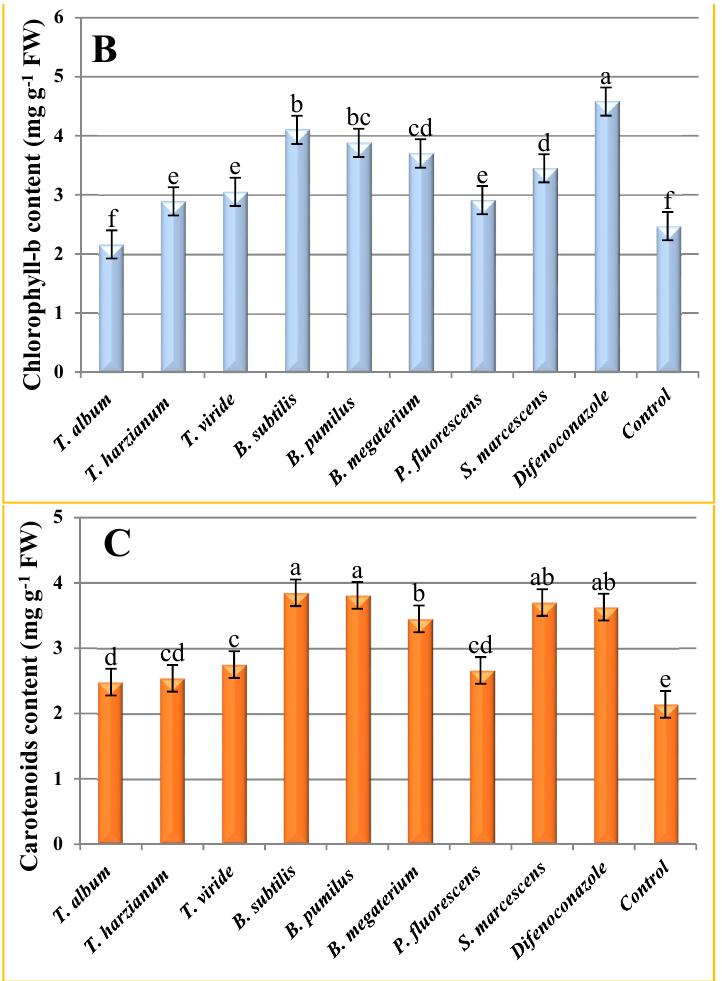
Figure 2. ( A ) Chlorophyll-a, ( B ) chlorophyll-b, and ( C ) carotenoids content (mg g − 1 FW) of celery plant grown under different treatments of biocontrol agents and synthetic fungicide. Data are mean of two repeated trials during the growing seasons 2018/2019 and 2019/2020, each with three replicates. Different letters (a, b, c, etc.) on the columns show significant differences between the treatments according to Duncan’s multiple ranges test at 0.05 statistical level, ± bars indicate to standard errors of the mean. Table 4. Peroxidase and polyphenol oxidase activities and total phenol content in powdery mildew-infected celery leaves in response to biocontrol agents and synthetic fungicide during the growing seasons 2018/2019 and 2019/2020 under field conditions.